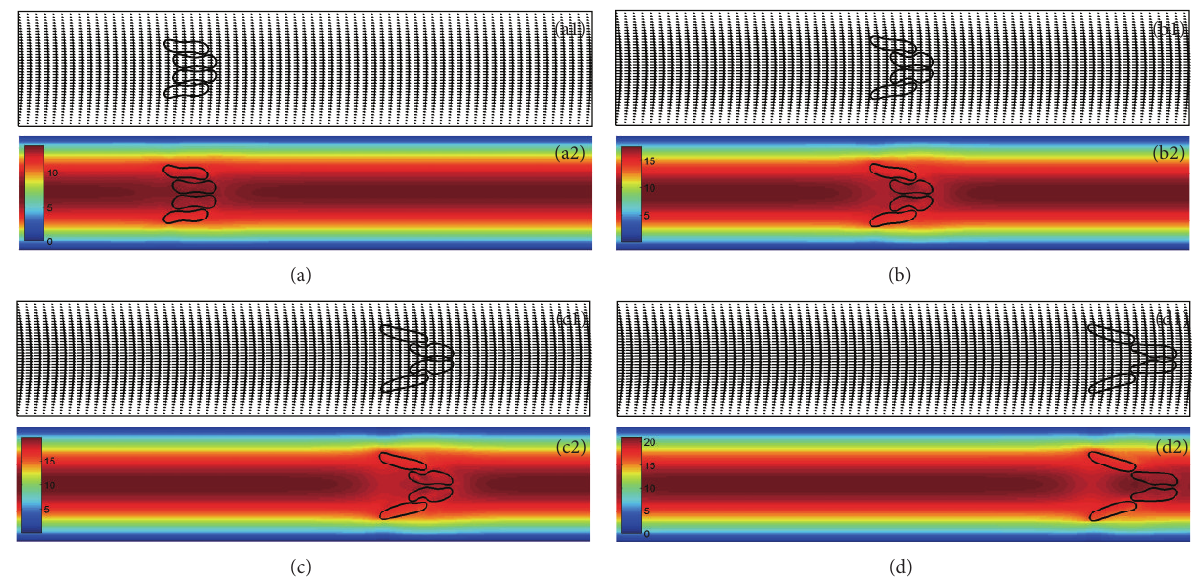
Figure 2: Motion and dissociation of a four-cell erythrocyte aggregate in a straight channel at time instants (a) 𝑡 = 0.28 ms; (b) 𝑡 = 0.42 ms; (c) 𝑡 = 0.55 ms; and (d) 𝑡 = 0.66 ms. Velocity vectors (a1-d1) and axial velocity magnitude contours (cm/s) (a2-d2) are presented. The initial configuration for the aggregate is shown in Figure 1(c), and the aggregate is horizontally placed in the channel initially. The parameters used are 𝐷 𝑒 = 1.0 × 10 −2 𝜇 J/m 2 , 𝑘 𝑏 = 5.0 × 10 −13 Nm.